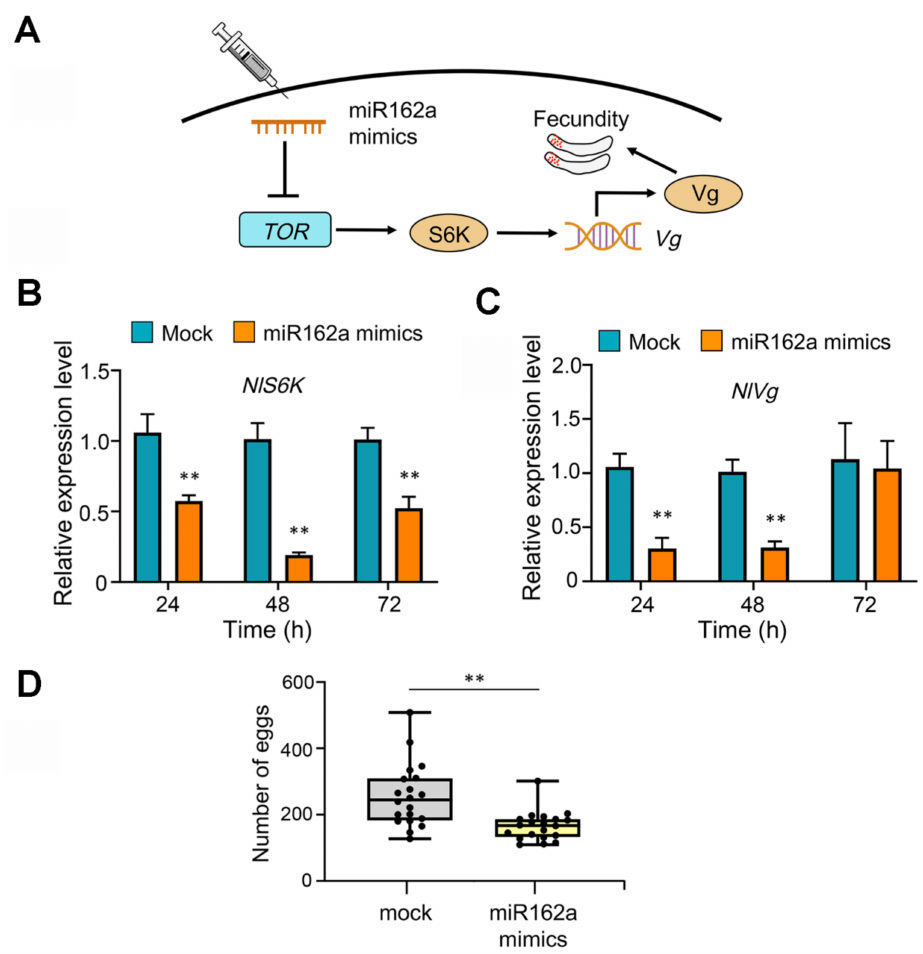
Figure 2. Injected osa-miR162a mimics impair the fecundity of BPH. ( A ) Schematic diagram of the effect of injected osa-miR162a mimics on weakening the TOR signaling-regulated fecundity in BPH. S6K is a downstream player of NlTOR in the TOR signaling and vitellogenin (Vg) is a molecular marker for assessing the fecundity of BPH. ( B , C ) Expression of NlS6K ( B ) and NlVg ( C ) is reduced in female adults injected with osa-miR162a mimics. The expression levels were quantified by RT-qPCR and the data are presented as mean ± SEM of three biological replicates ( n = 3). The expression levels of NlS6K and NlVg after injection with negative control miRNA mimics at different time points were normalized as 1. ( D ) Number of eggs per female adult in the fecundity assay. Eggs from 20 female adults were counted and individual data points are shown as dots. ** p < 0.01 (student’s t